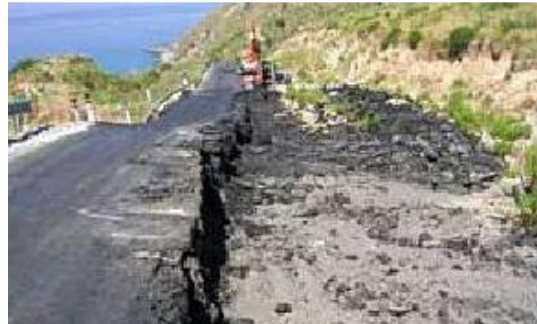
Figure 3. Deep cracks in the road